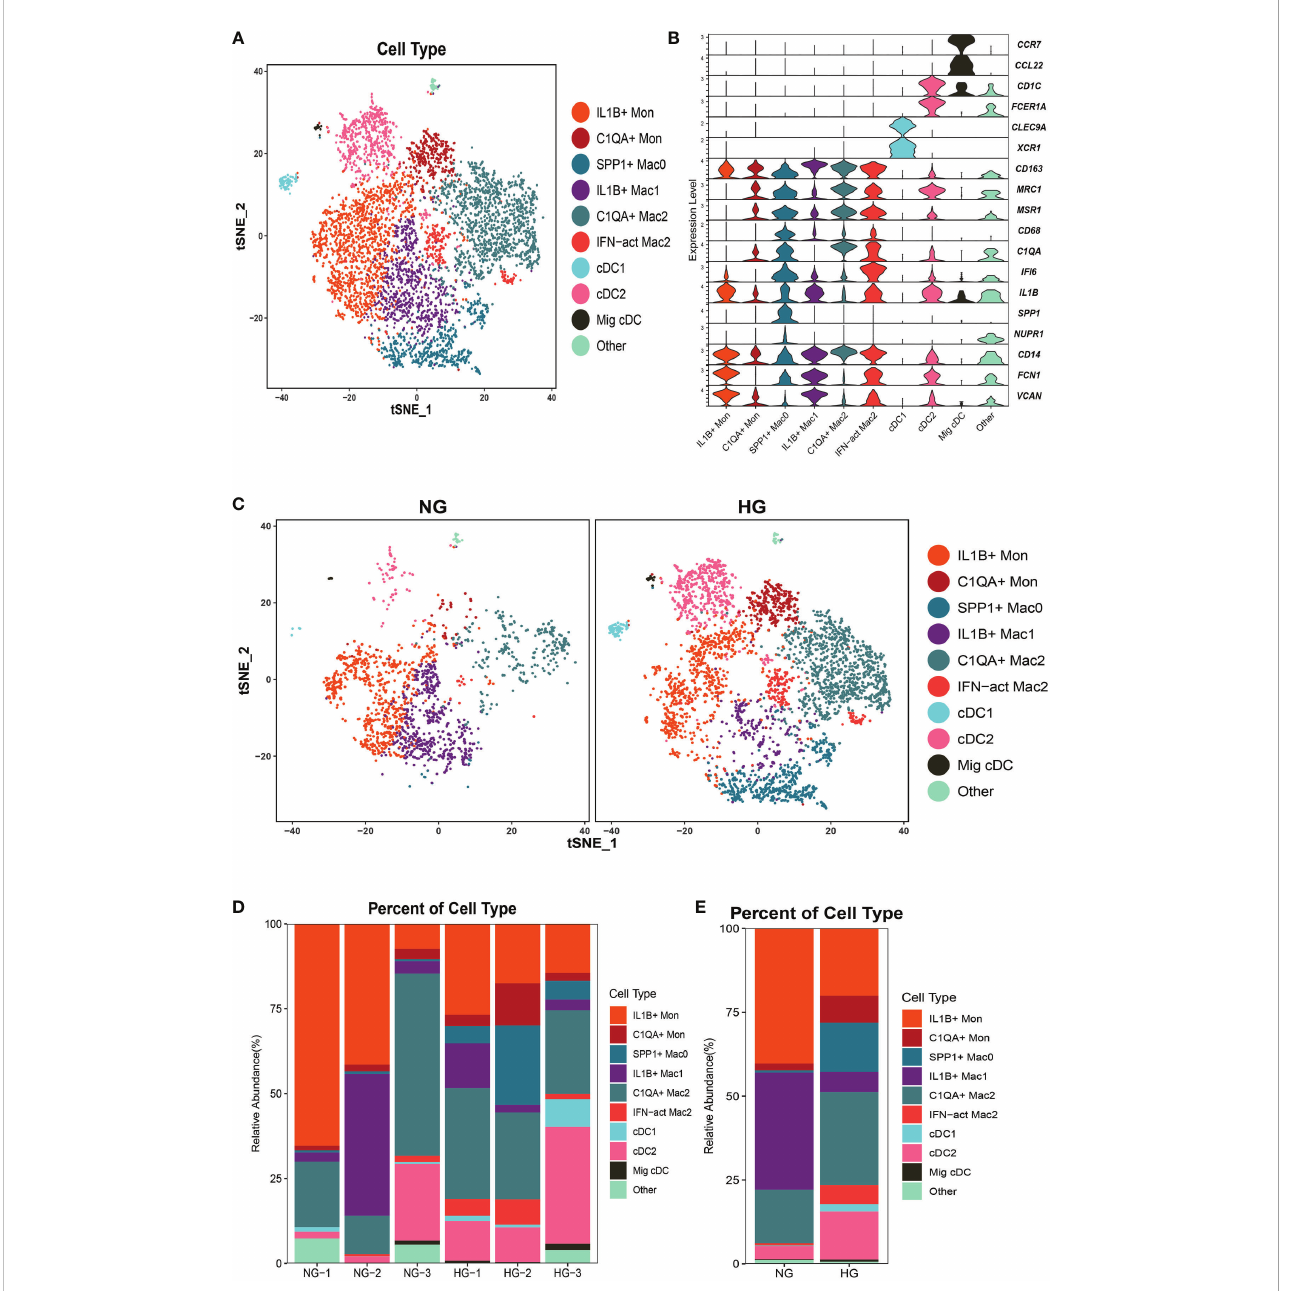
FIGURE 5 Clustering and classi fi cation of the myeloid cell subclusters from deep fascia tissue (A) tSNE visualization of myeloid cell subclusters from deep fascia tissue. (B) Violin plots showing marker genes across myeloid cell subclusters. (C) tSNE visualization of myeloid cell subclusters from deep fascia tissue in HG and NG. (D) Bar plots showing the relative percentage of myeloid cell subclusters for each sample. (E) Bar plots showing the relative percentage of myeloid cell subclusters in HG and NG. HG, high stress group; NG, normal stress group; Mac, macrophage; DCs, dendritic cells; Mon,